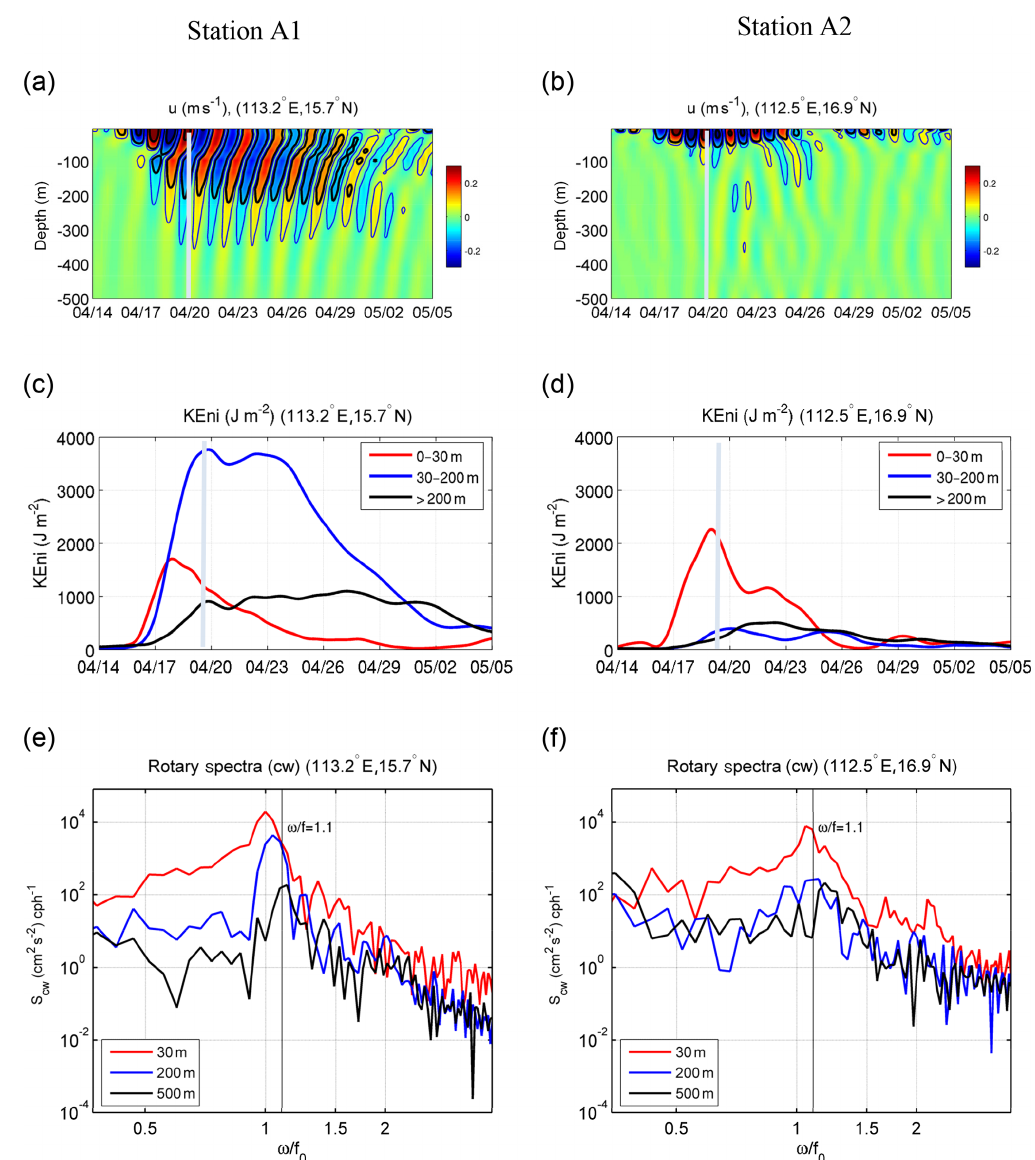
Figure 9. Time series of (a, b) u i (ms − 1 ), (c, d) KEni (Jm − 2 ), and (e, f) rotary spectra (cw component) at locations A1 (a, c, e) and A2 (b, d, f)